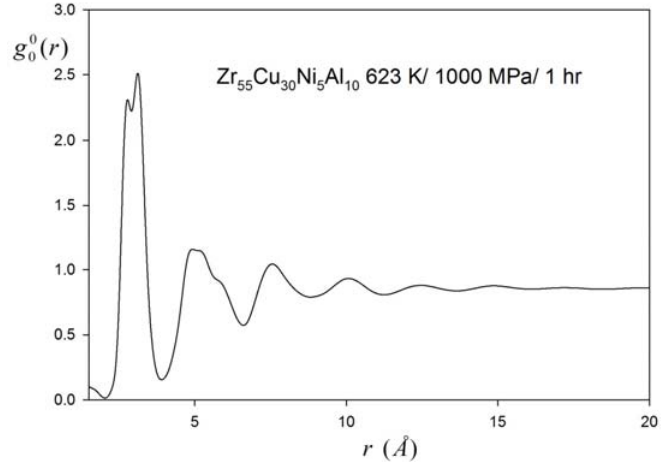
Figure 4. Isotropic PDF, g 00 ( r ).